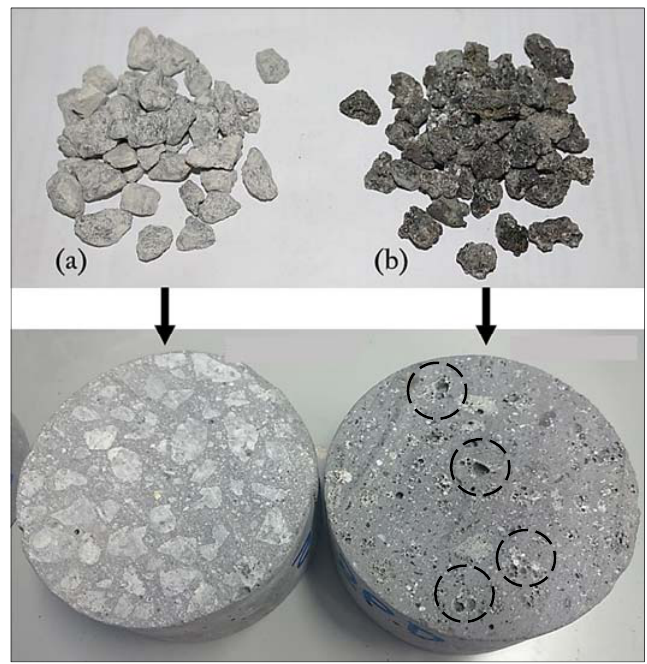
Figure 11. Difference in porosity of concrete. ( a ) Granite; ( b ) POC.